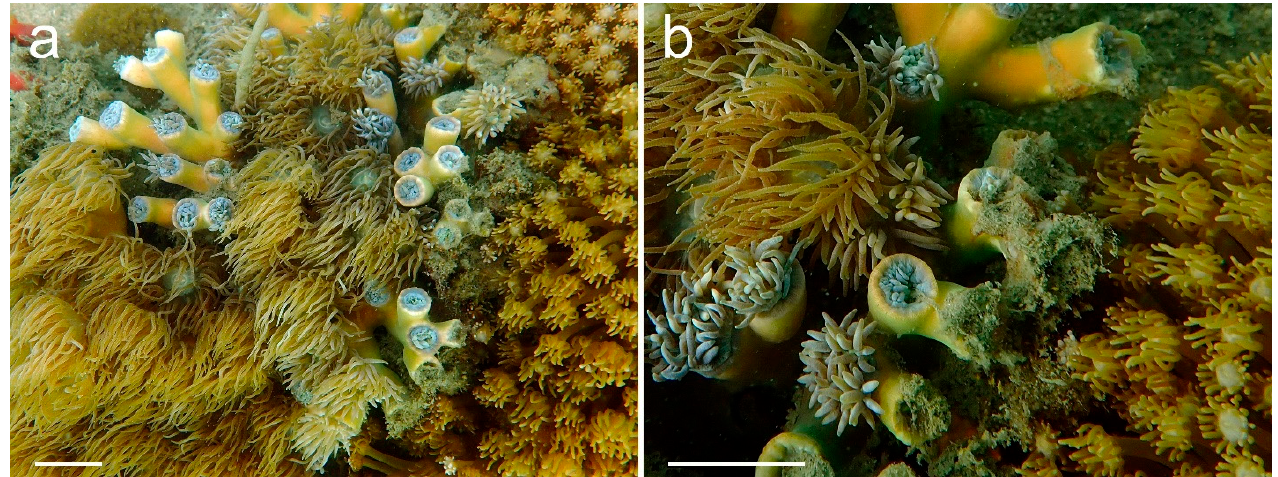
Figure 4. Overview ( a ) and close ‐ up ( b ) of a Duncanopsammia axifuga colony (left ‐ hand side) with stretched tentacles showing damaged and dead coral polyps that are in contact with a Goniopora colony (right ‐ hand side). Scale bars: 2.5 cm.